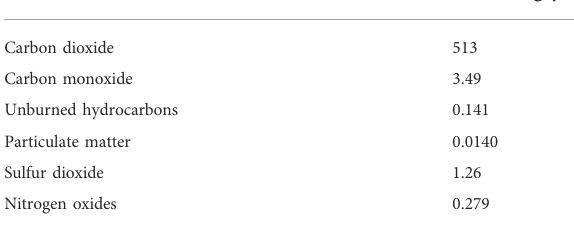
TABLE 5 Pollution emission